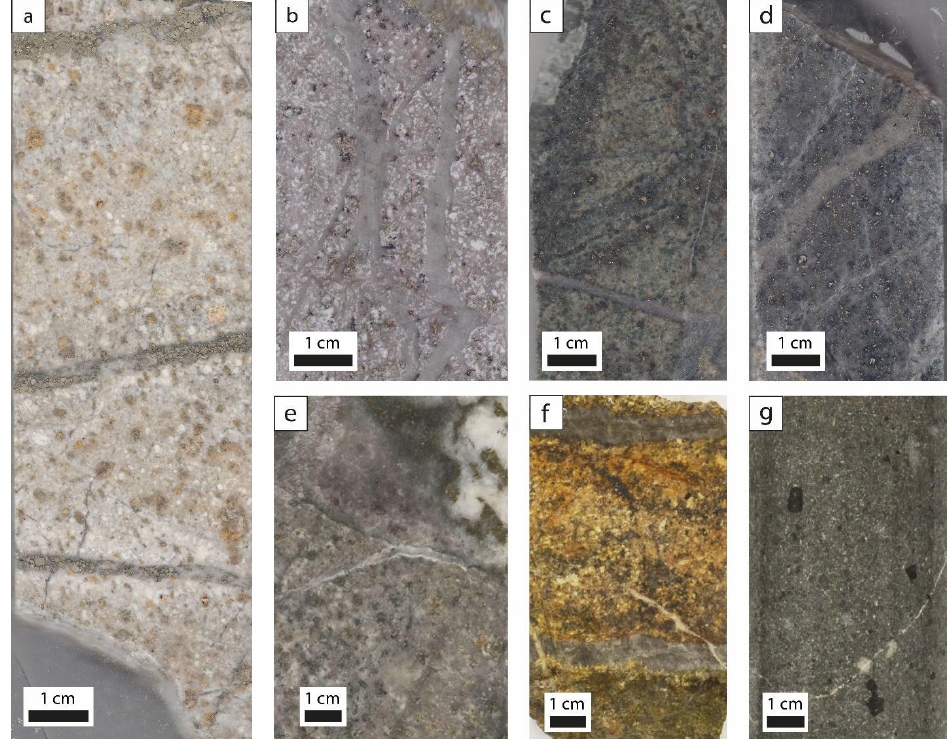
Figure 5. Samples selected for geochronology and zircon trace element analysis. ( a ) Altered Phase I andesite overlying Borska Reka and Tilva Ros deposits, with pyrite-anhydrite veins; B67-373; ( b ) Fine-grained diorite dyke from shallow levels of Borska Reka porphyry, with sinuous quartz veins, disseminated covellite; BGM1-64; ( c ) Deep, heavily altered Phase I andesite from Borska Reka porphyry, with quartz-pyrite-chalcopyrite veins and pyrite-anhydrite veinlets with chlorite-sericite halos; BGM3-312; ( d ) Deep Borska Reka porphyry with prominent chalcopyrite-pyrite dissemina- tions and hairline pyrite stringers; BGM1-314; ( e ) P1 porphyry from Cukaru Peki, pervasively al- tered, with anhydrite-pyrite vein crosscutting quartz-pyrite vein; TC160125B-1464.5; ( f ) P2 crowded diorite porphyry from Cukaru Peki, with quartz-pyrite-chalcopyrite vein cross-cut by a gypsum vein; FMTC1328-914.5; ( g ) Post-mineral fine-grained P10 diorite porphyry from Cukaru Peki; TC160125-1360.4. Sample labels throughout contain the number of the drill hole (i.e., BGM1) fol- lowed by the depth of the sample relative to the collar of the drill hole (i.e., 314 m). Porphyry-style mineralization is present in deeper parts of the deposit, with quartz, anhydrite, magnetite and chalcopyrite veins and chalcopyrite disseminations (Figure 6a); the top of this porphyry zone is outlined at 1000 m below the surface [45]. For comparison, the top of the porphyry-style magnetite-chalcopyrite vein mineralization (Figure 6b) at Borska reka is located at approximately 800 m depth. The transitional zone at Cukaru Peki overlies the porphyry zone, with covellite and enargite replacing chalcopyrite (Figure 6d,g); anhydrite, calcite and gypsum veins with pyrite and covellite being the prevalent vein types [46]. Epithermal veins with covellite, anhydrite and enargite cross-cut quartz- chalcopyrite-pyrite veins at Bor (Figure 6f). High-grade massive sulfides at Cukaru Peki (Figure 6i), as well as pyrite-covellite veins (Figure 6h) and hydrothermal breccias repre- sent the shallow part of the deposit and are found at depths from 400 to 1000 m below the surface; at Bor, recently mined T and T1 massive sulfide orebodies (Figure 6j) are located at depth of 500 m below the surface, and historic Coka Dulkan and Tilva Mika were out- cropping at the pre-mining surface.